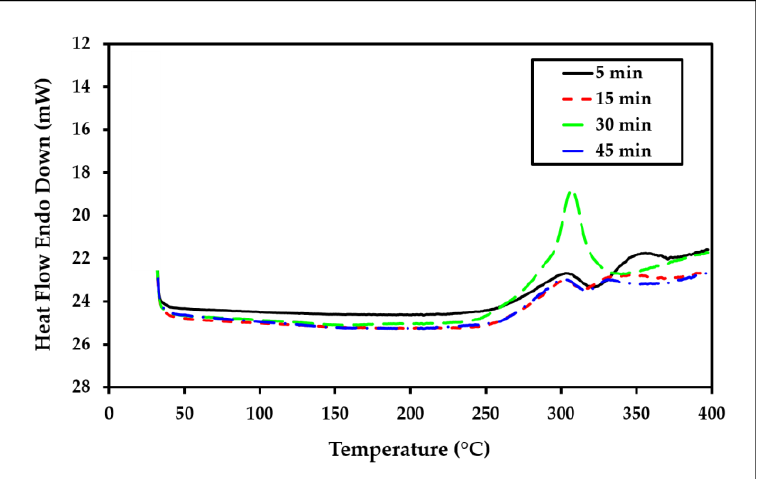
Figure 11. DSC thermograms of the all-cellulose composites after 5, 15, 30, and 45 min of dissolution time.